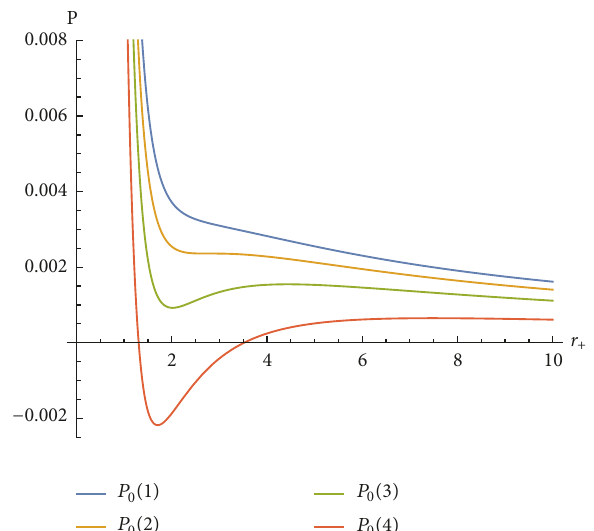
Figure 4: 𝑃−𝑟 + diagram of charged AdS black holes in the rainbow gravity. The temperatureof isotherms decreases from top to bottom. The 𝑃 0 (1) line corresponds to one-phase for 𝑇 > 𝑇 푐 . The critical state, 𝑇 푐 = 0.0358 , is denoted by the 𝑃 0 (2) line. The lowest two lines correspondto thesmaller temperaturethan the critical temperature.